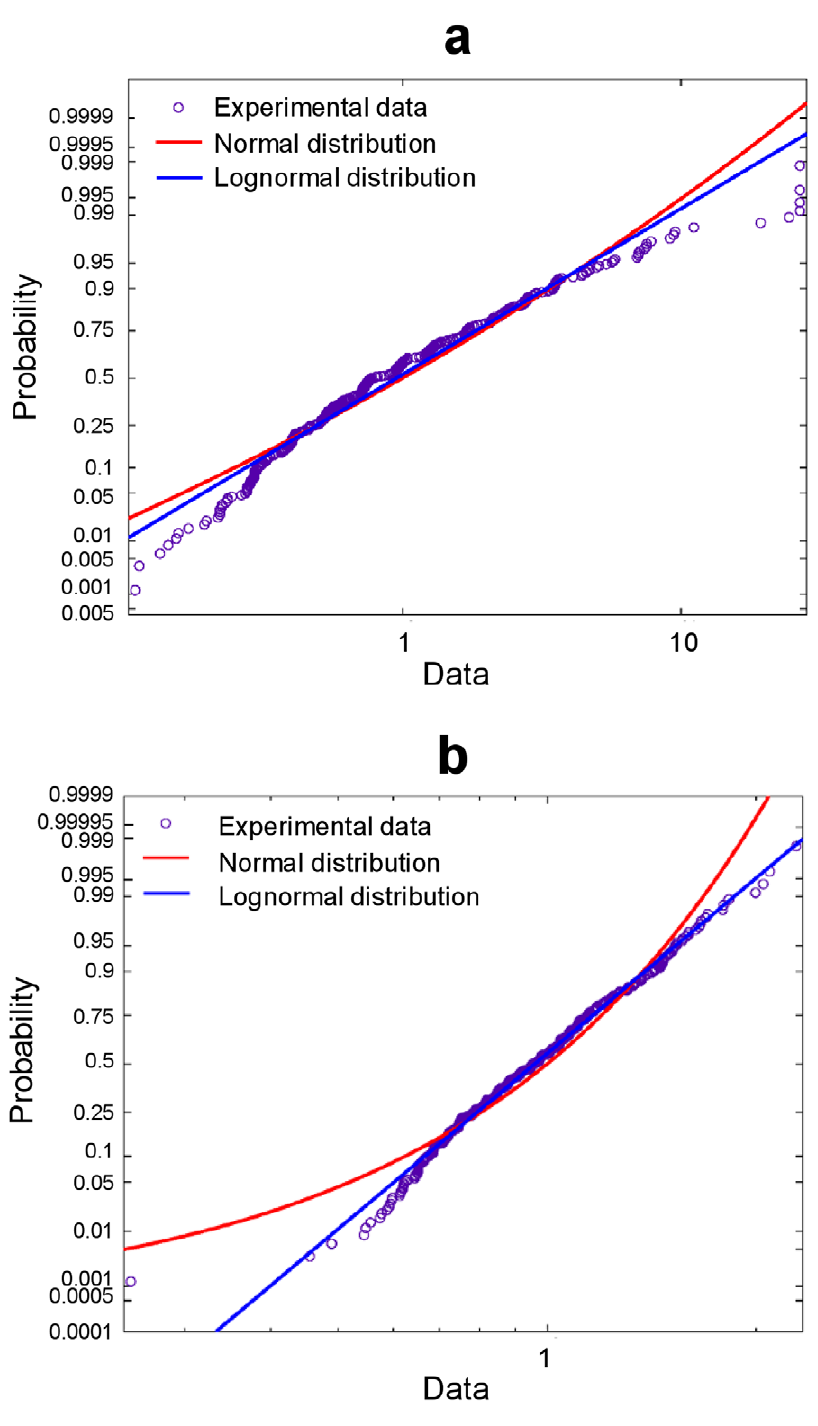
Figure 4. Distributions of time intervals. ( a ) Probability plot for the duration of the pen-on-paper period together with probability plots for theoretical normal and lognormal distributions. ( b ) Probability plot for time of reaction together with probability plots for theoretical normal and lognormal distributions. In both cases, the plot scales are chosen to have a direct line for the lognormal distribution.